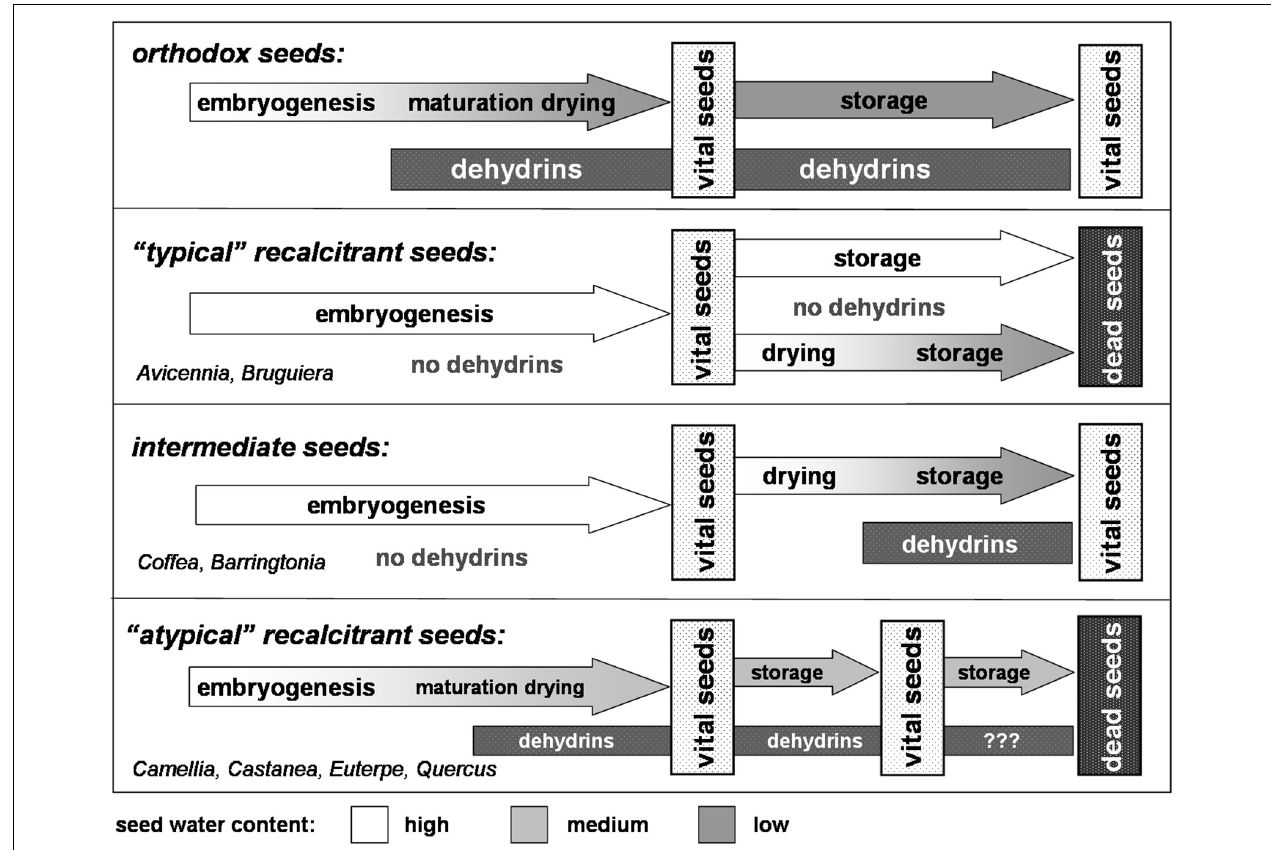
FIGURE 1 | Dehydrin expression and maturation drying–An adjustment to the chain of events (according to Radwan et al., 2014).